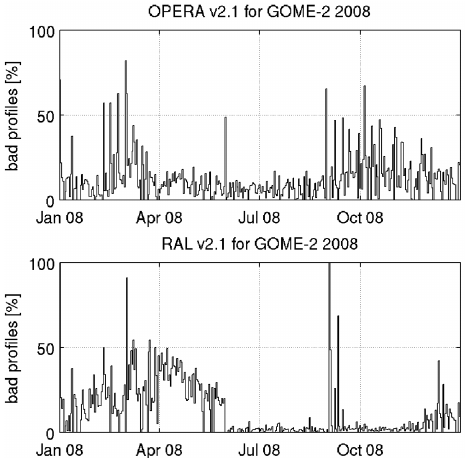
Figure 2. Daily relative amount of “bad” (filtered) GOME-2 pro- files (2008 only) in the OPERA v1.26 and RAL v2.1 global cover- age and station overpass data sets